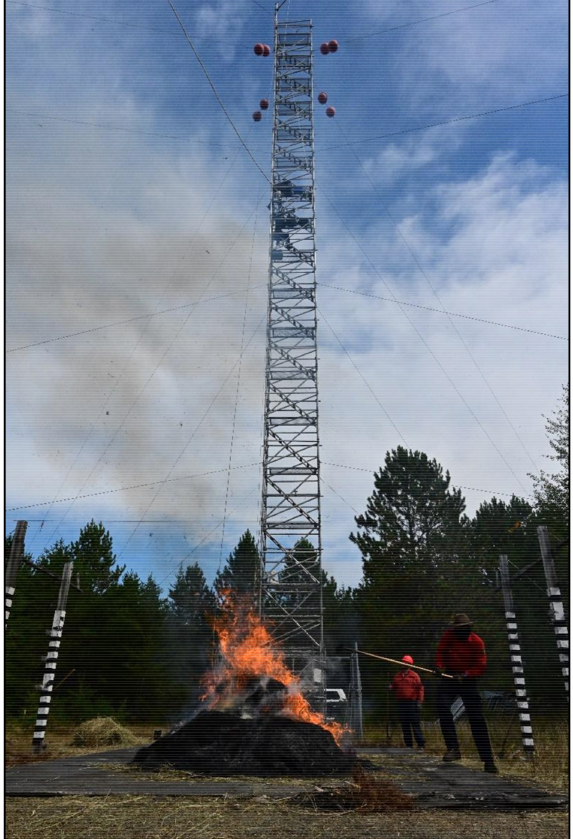
Figure 3. Example of experimental burn trials conducted 18 September 2019 during this experiment. Pictured here, researchers add fuel to a ~2 m diameter fire with a pitchfork while it is sampled by Bomberos and the reference FLIR imager on the tower adjacent to the burn